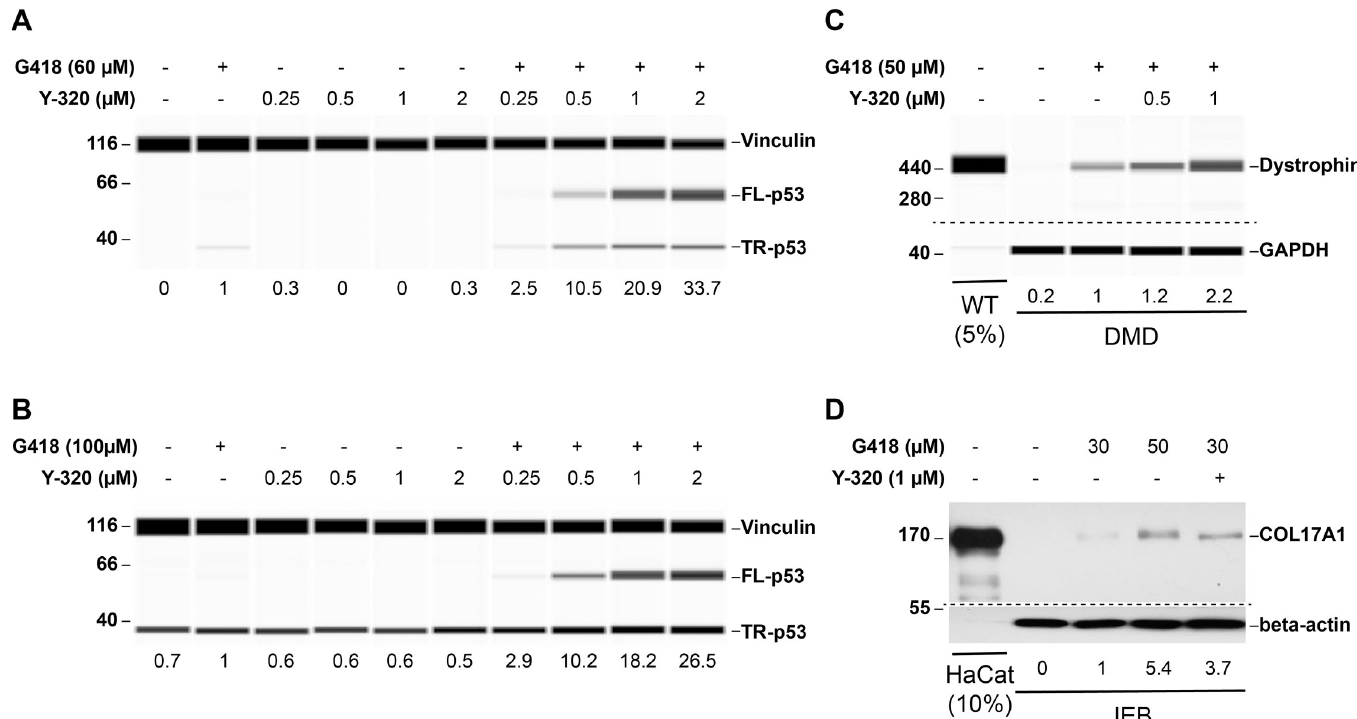
Fig 2. Y-320 enhances PTC readthrough by G418 in different cell lines. (A) p53 PTC readthrough in HDQ-P1 cells exposed to the indicated compounds for 48 h. Shown are pseudo blots of chemiluminescence of bound p53 and vinculin antibodies. The area under the FL-p53 peaks was first normalized to the vinculin loading control and then divided to that of G418 to provide lane-to-lane comparison. These numbers are displayed under the lanes. The MW ladder in kDa is shown at the left. (B) p53 PTC readthrough in H1299-R213X cells exposed to the indicated compounds for 24 h and imaged as in panel A. (C) Dystrophin PTC readthrough. WT and DMD patient-derived myoblasts were exposed to the indicated compounds in differentiating medium for 5 days. The proteins were separated using high-molecular weight capillaries. Shown are pseudo blots of bound dystrophin and GAPDH antibodies. The area under the dystrophin peaks was first normalized to the GAPDH loading control and then divided to that of G418 to provide lane-to-lane comparison. These numbers are displayed under the lanes. The amount of WT protein run in the capillary was 5% of that of DMD cells. (D) Collagen XVII PTC readthrough. Junctional Epidermolysis Bullosa patient-derived keratinocytes (JEB01) were exposed to the indicated concentrations of G418 and Y-320 for 72 h. COL17A1 protein levels were determined by traditional western blotting. The blots were scanned and COL17A1 band intensities were measured and normalized to the beta-actin loading control using ImageJ. The values are expressed relative to 30 μ M G418 conditions to provide lane-to-lane comparison and are displayed under the lanes. The amount of HaCat protein run in the capillary was 10% of that of JEB cells. Dashed lines indicate different capillaries or blots. Uncropped images of automated capillary electrophoresis western analyses are provided in S1 Raw Images. DMD, Duchenne Muscular Dystrophy; FL- p53, full-length p53; GAPDH, glyceraldehyde-3-phosphate dehydrogenase; MW, molecular weight; PTC, premature termination codon; TR-p53, truncated p53; WT,